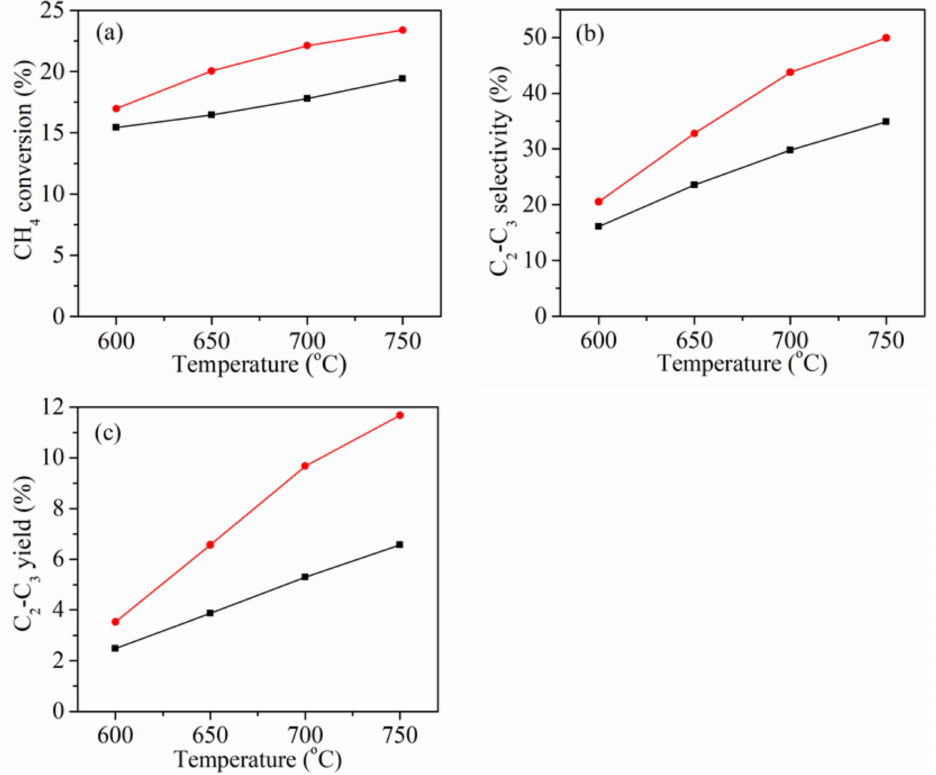
Figure 1. CH 4 conversion ( a ), C 2 -C 3 selectivity ( b ) and C 2 -C 3 yield ( c ) as a function of reaction temperature for the Ho 2 O 3 catalysts. ( (cid:4) ) Ho 2 O 3 -NP (nanoparticles), ( • ) Ho 2 O 3 -NS